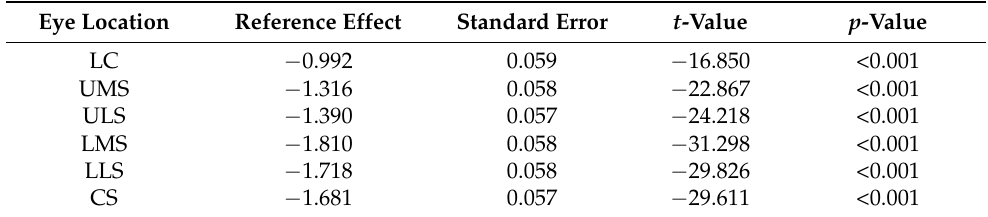
Table 4. The distribution of estimates of reference effect, standard error, t -value and p -value of the different anatomical locations across the eye compared to the medial canthus.